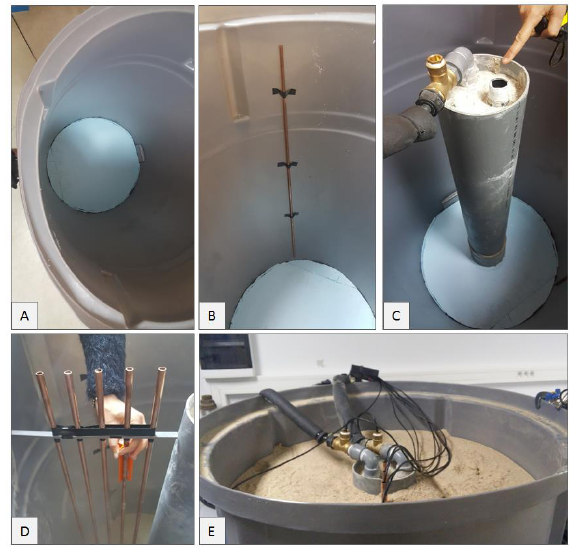
Figure 2. Installation of the experimental setup: ( A ) Thermal insulation of the main container, ( B ) main container and first cupper tube, ( C ) geothermal borehole placement, ( D ) Set of cupper tubes set to equal distances, and ( E ) overview of the setup with all the sensors and accessories.